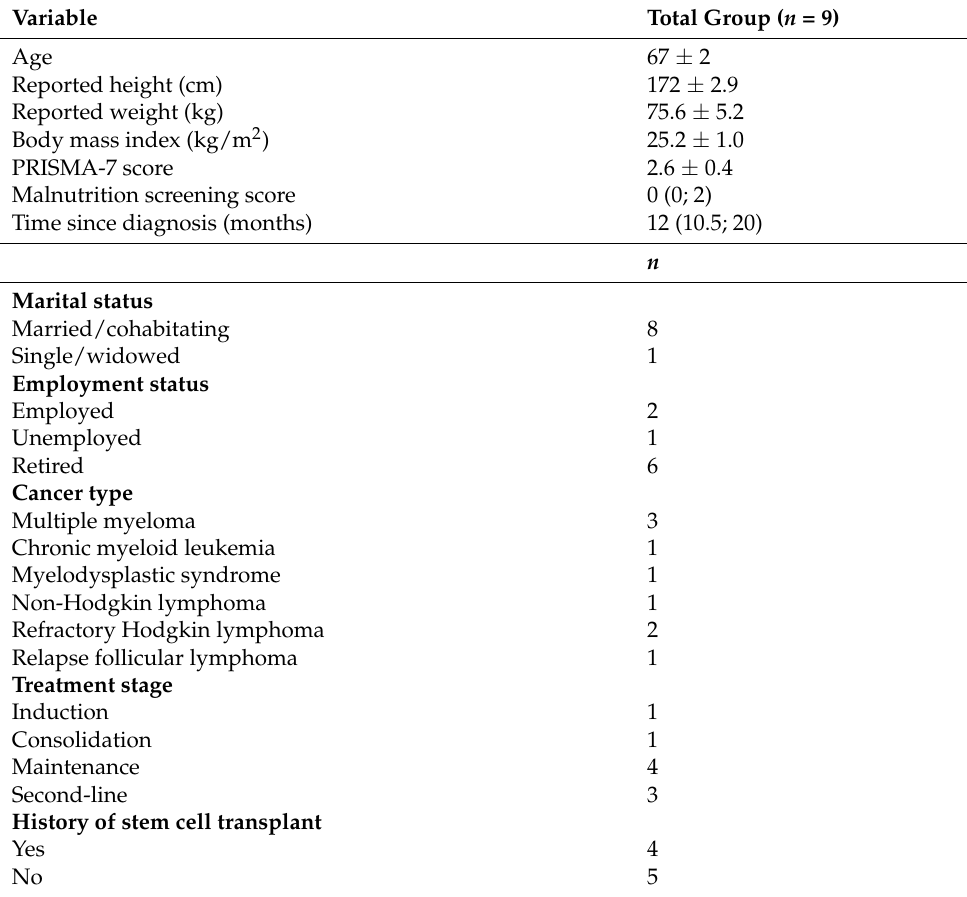
Table 1. Demographic information, frailty and malnutrition risk of participants.